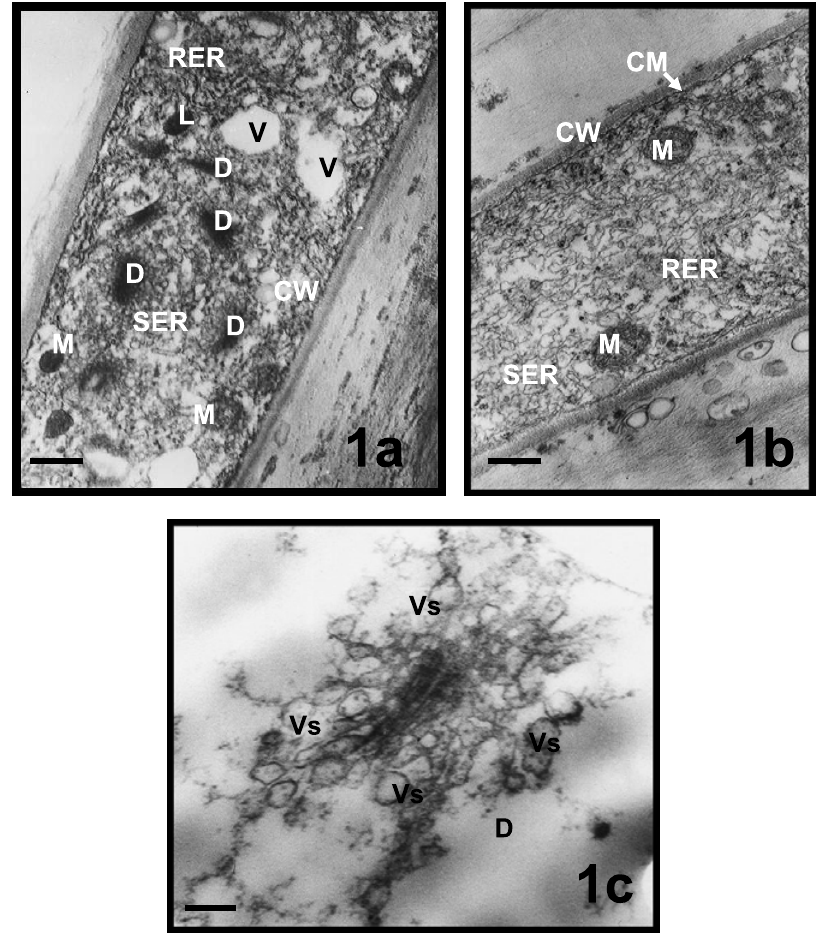
Fig. 1 – Apical zones of pollen tubes in Mimulus aurantiacus . a, b, views from apical zone; c, well-developed dictyosome in the apical zone. a, bar = 1 μ m; b, bar = 0 , 5 μ m; c, bar = 150 nm. (CM, cell membrane; CW, cell wall; D, dictyosome; L, lipid; M, mitochondria; RER, rough endoplasmic reticulum; SER, smooth endoplasmic reticulum; Vs,